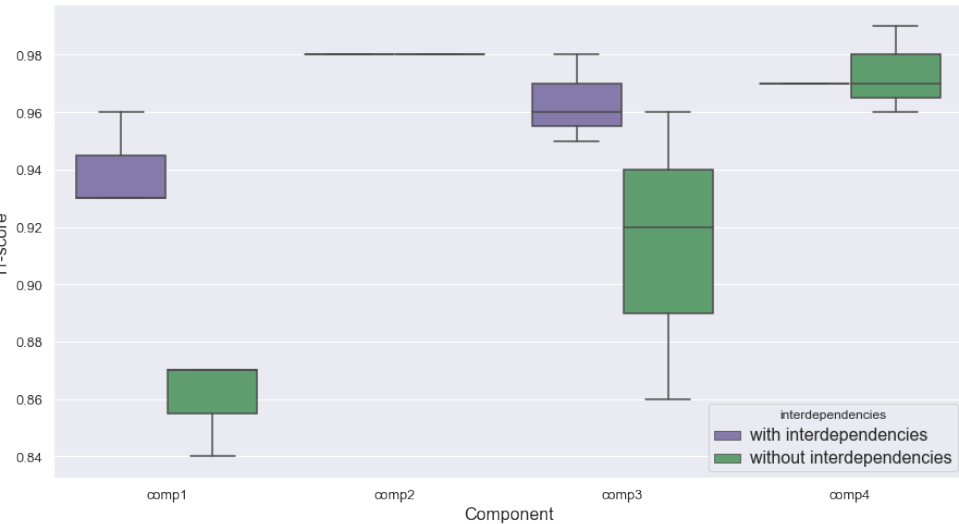
Figure 5. Estimation of interdependencies effect between components through comparison of predic- tive results. In purple are shown predictive results including interdependencies. Whereby, in green the predictive results excluding interdependencies are presented. Significant interdependencies are visible in components 1 and